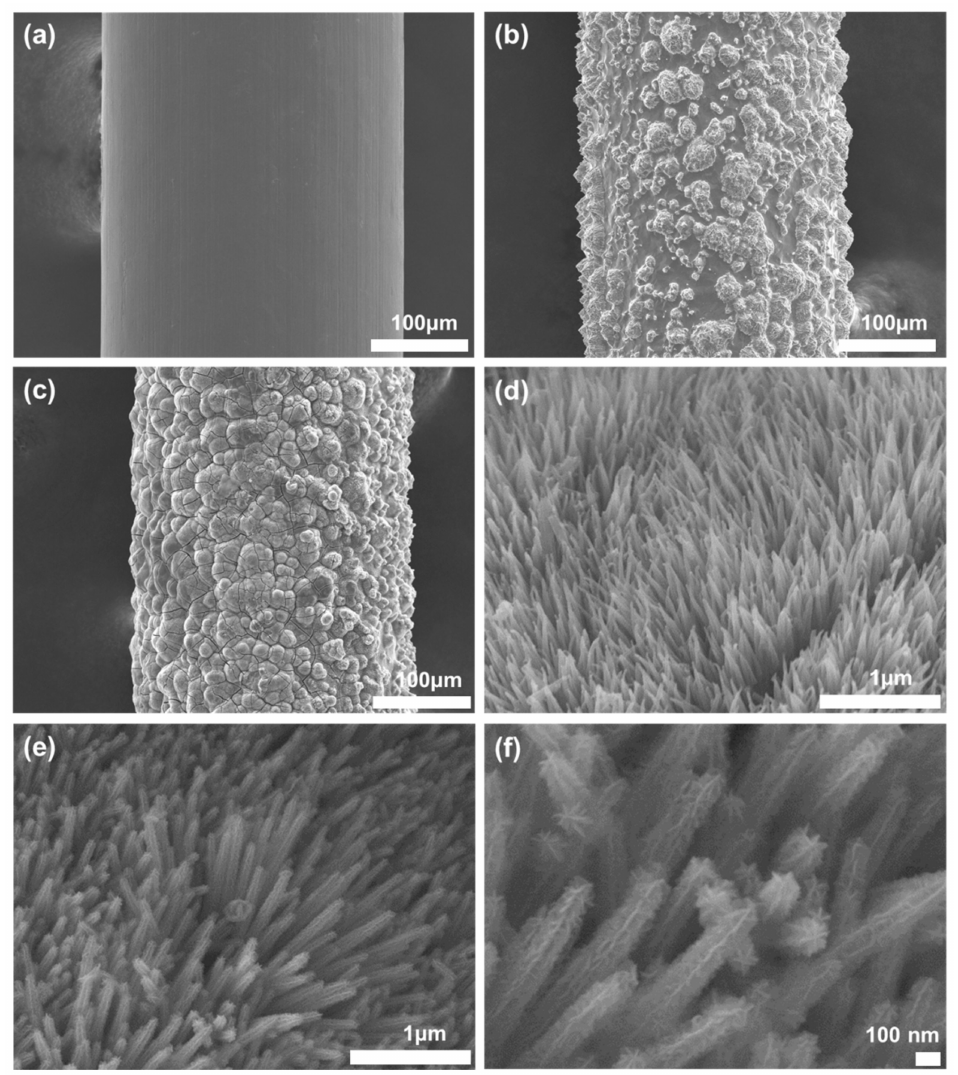
Figure 8. ( a ) Bare Ni wire; ( b ) etched Ni wire; ( c ) NiCo 2 O 4 / MnO 2 hierarchical nanostructures grown on etched Ni wire; ( d ) magnified view of NiCo 2 O 4 nanoneedles; ( e ) and ( f ) magnified views of NiCo 2 O 4 / MnO 2 hierarchical